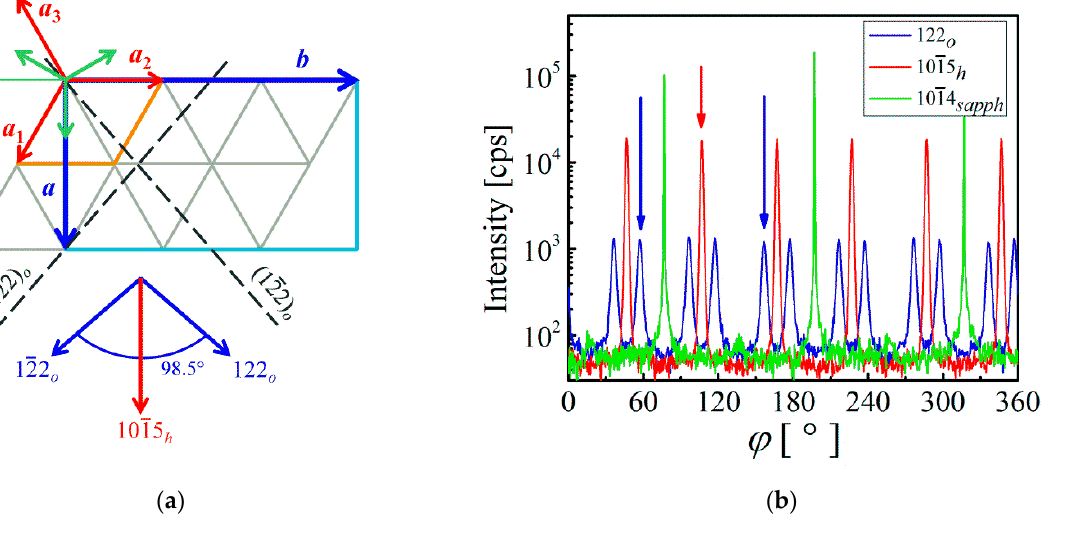
Figure 2. ( a ) Schematic drawing of the coincidence of the ε -Ga 2 O 3 , κ -Ga 2 O 3, and the c -sapphire lattices. The crystallographic axes of hexagonal and orthorhombic Ga 2 O 3 within the plane (0001) of sapphire substrate are shown as blue and red arrows, respectively. The green arrows are the hexagonal axes of sapphire substrate. Black dashed lines represent the intersections of the planes ( 122 ) o and (cid:0) 122 (cid:1) of the orthorhombic lattice with the plane of interface. The blue and red arrows in the lower part of the figure are the projections of three particular diffraction vectors into the plane of interface; ( b ) ϕ scans of the selected diffractions of orthorhombic Ga 2 O 3 (blue line), hexagonal Ga 2 O 3 (red line), and sapphire (green line). Three selected maxima that correspond to diffraction vectors in ( a ) are marked by blue and red arrows, respectively. Note that the hexagonal Ga 2 O 3 lattice is rotated by 30 ◦ with respect to the sapphire